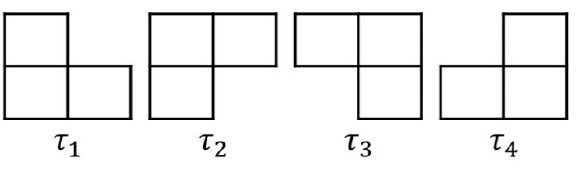
Figure 1. ‘T’ set of Tromino pieces.